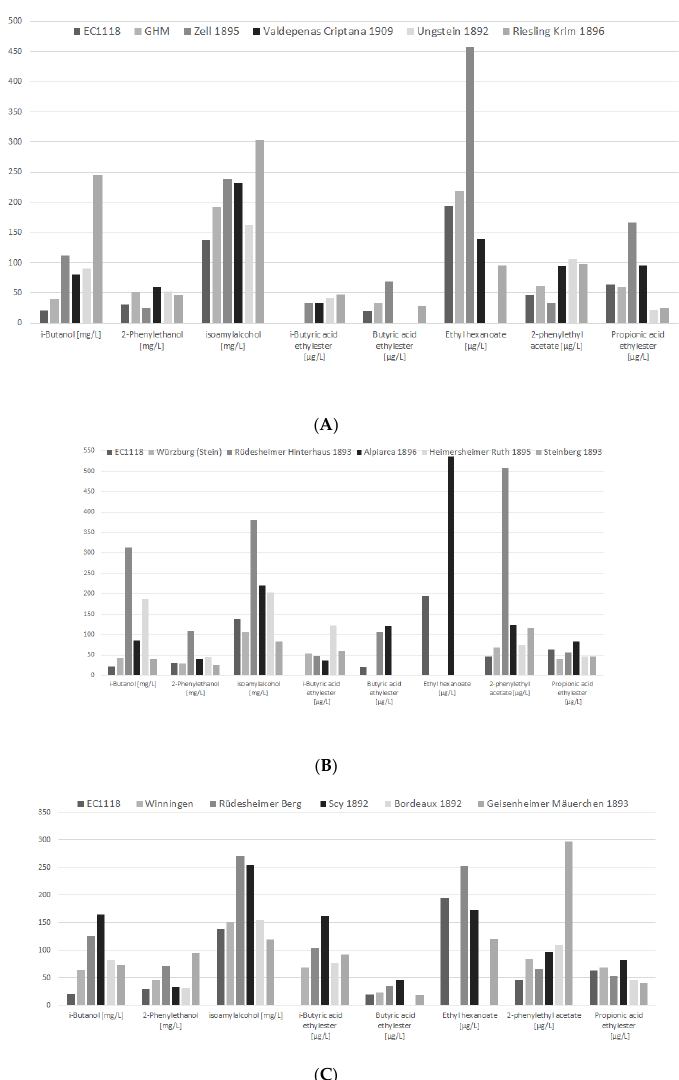
Figure 3. ( A – C ) . Bar charts with selected alcohol (in mg/L) and ester (in µg/L) aroma compounds of Figure 3. ( A – C ). Bar charts with selected alcohol (in mg / L) and ester (in µ g / L) aroma compounds Saccharomyces strains compared to the EC1118 wine yeast. Flavor compounds were measured using gas chromatography at the end of fermentation. The full list of aroma compounds is shown in Table S1.